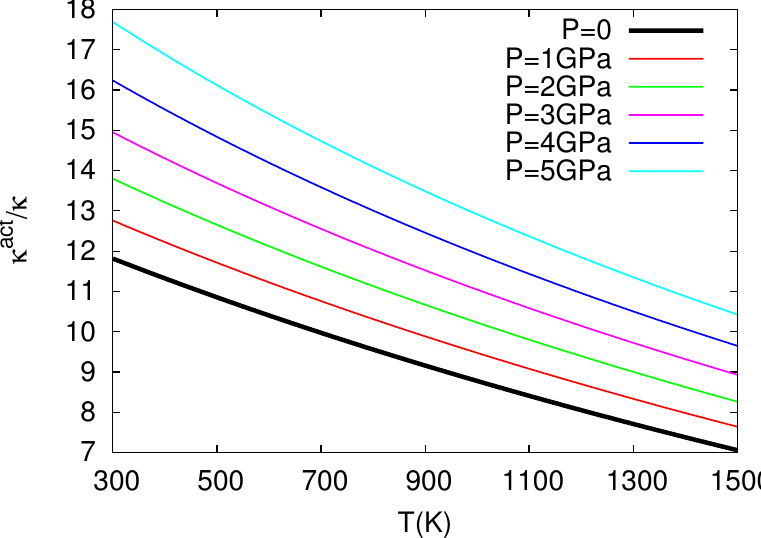
Figure 3. The κ act / κ values versus temperature (P = const) plotted for several